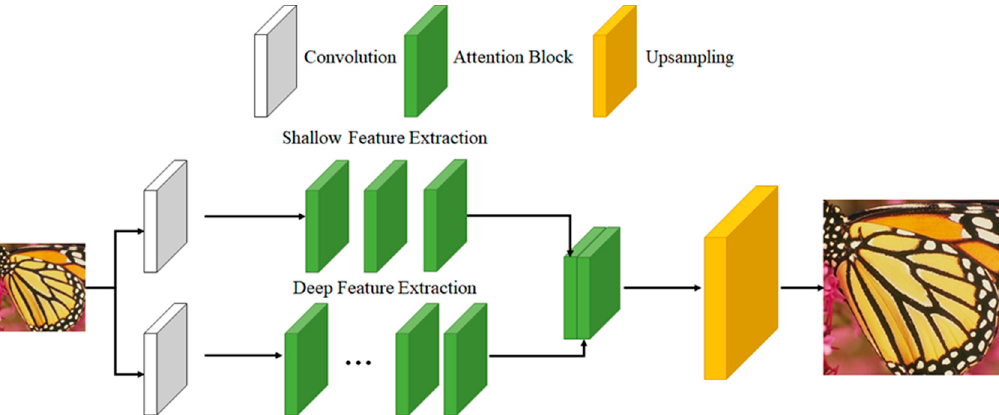
Figure 7. Proposed Method Architecture.